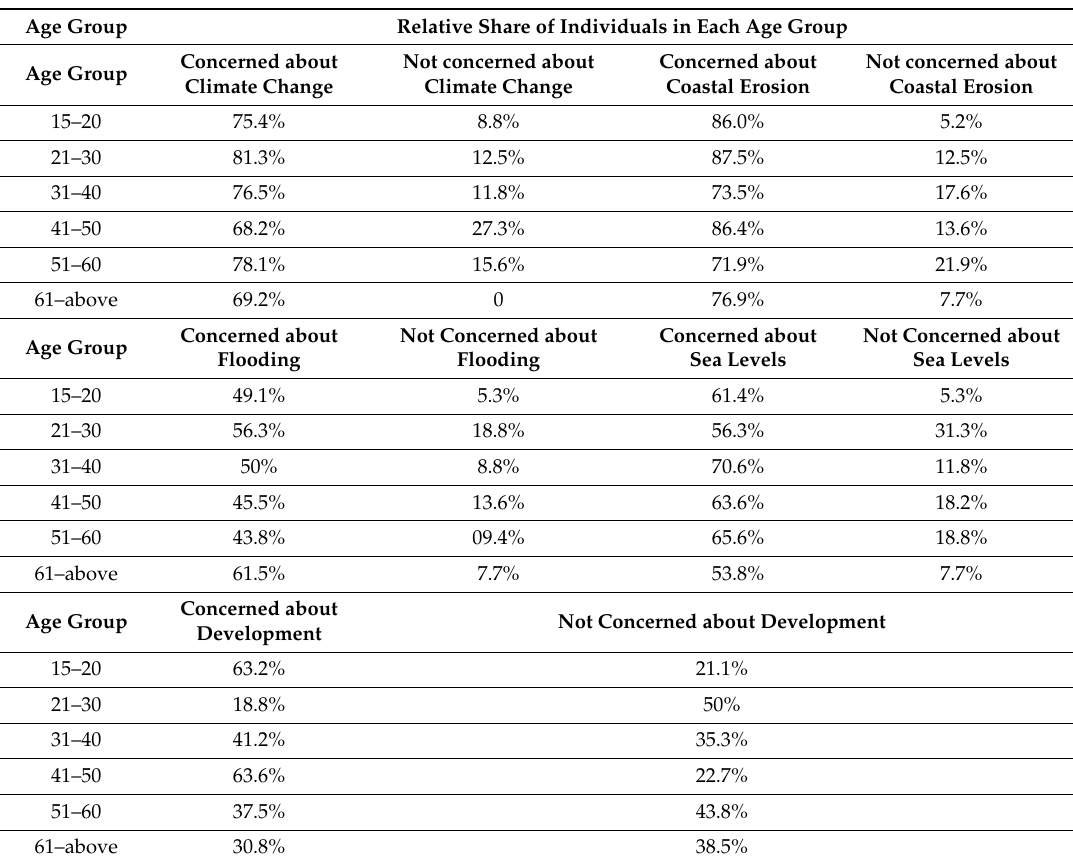
Table 5. Perceptions of environmental and social challenges by age group: St. Kitts.